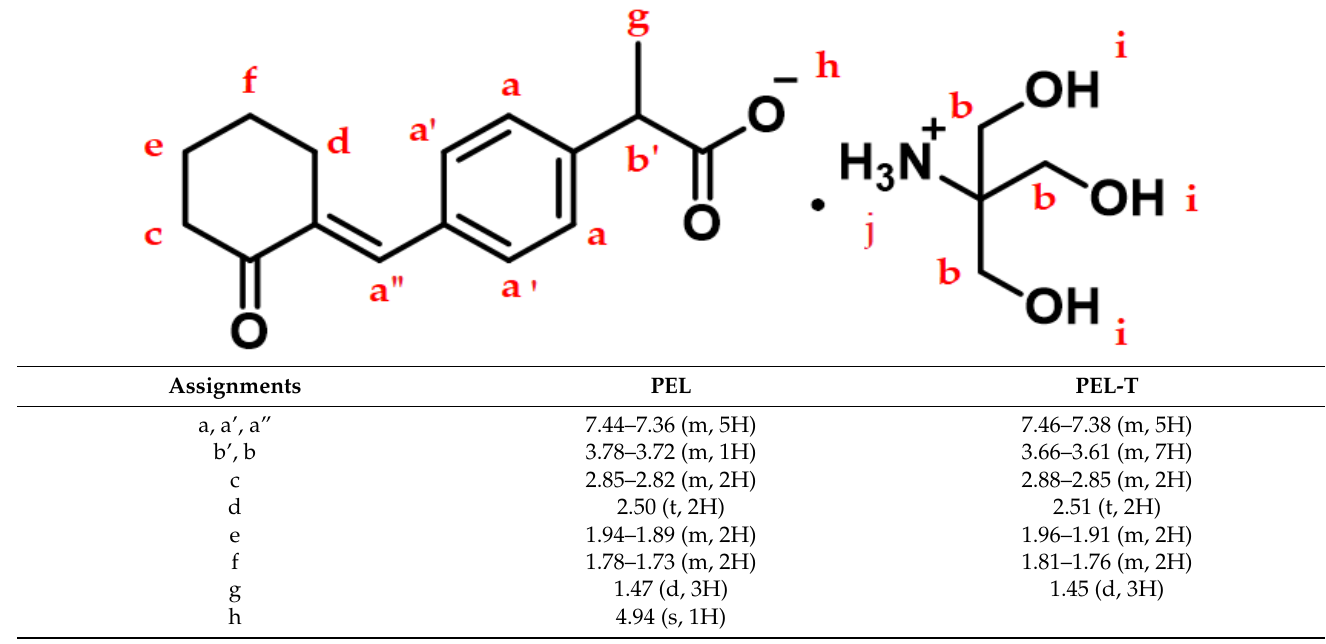
Table 1. 1 H NMR (500 MHz, methanol- d4 ) chemical shifts ( δ ), multiplicities, and assignments of PEL and PEL-T.